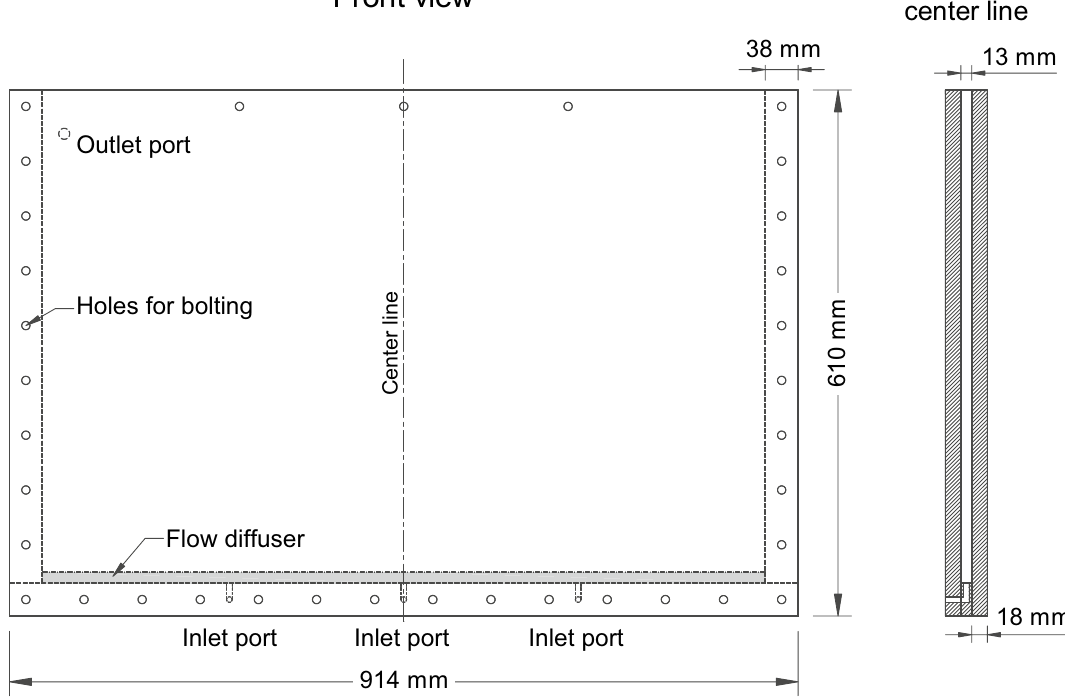
Figure 1. Transparent two-dimensional tank used to explore the effects of dissolution on slope